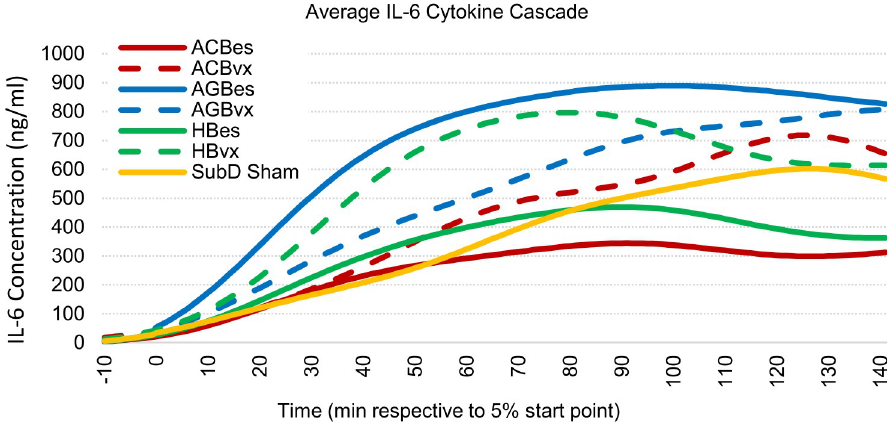
Fig 8. Averaged IL-6 cascade responses to IP injection of LPS (5 mg/kg). All samples were curve fitted and aligned at the time they reached 5% of peak concentration, represented as time “zero.” Time axis extends to the last time point at which all samples were still